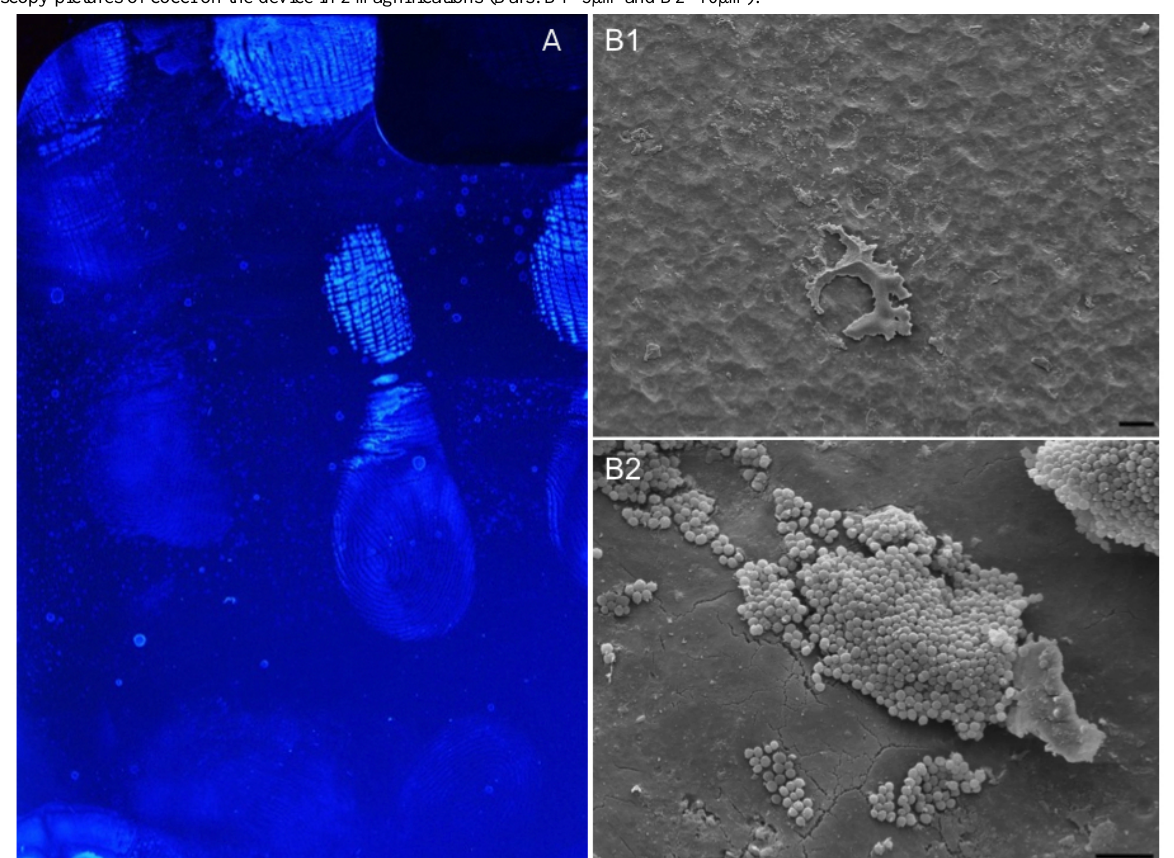
Figure 1. Aluminium backside of a tablet PC with fingerprints and other residue visible under fluorescent light and corresponding scanning electron microscopy pictures of cocci on the device in 2 magnifications (Bars: B1=5µm and